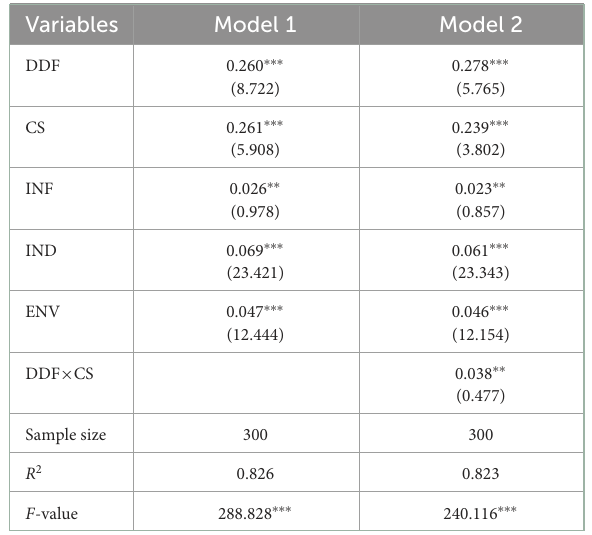
TABLE 5 Ordinary panel regression